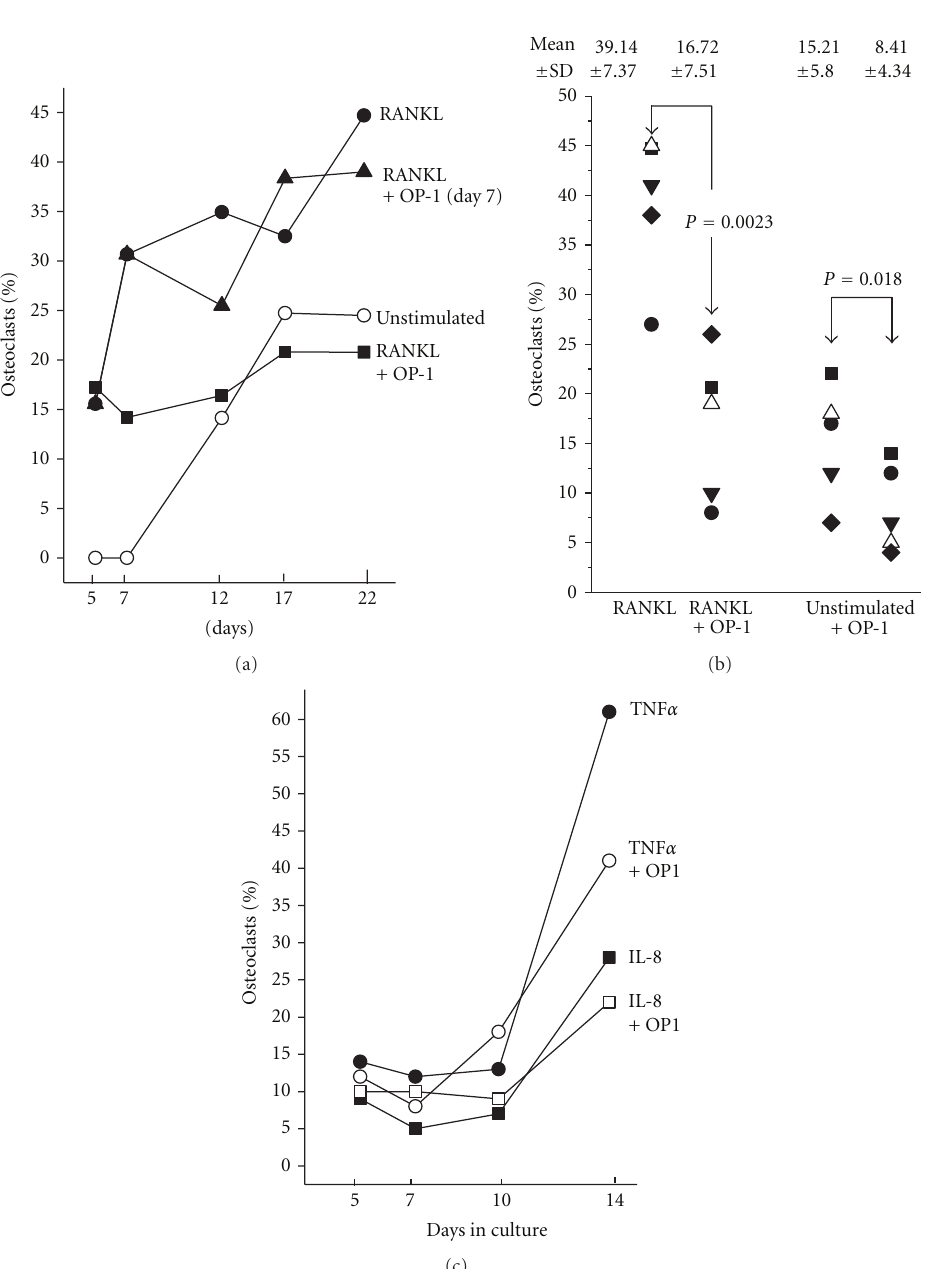
Figure 2: Di ff erentiation of CD14+ monocytes to osteoclasts in culture. (a) Monocytes were cultivated with RANKL (50ng/mL) ( • ), RANKL, and OP-1 (1 μ g/mL) ( (cid:2) ) or cultivated without stimulation ( ◦ ). In parallel, cells were cultivated for 7 days with RANKL, and then OP-1 was added ( (cid:3) ). At days 5, 7, 12, 17, and 22 the number of osteoclasts in relation to the total cell number was calculated (given are the mean values of triplicates with cells from one donor). (b) Monocytes of five individuals (each symbol stands for one individual) were cultivated with RANKL or with RANKL+OP-1 or left unstimulated with or without OP-1. After 22 days the percentage of osteoclasts was calculated (the mean values of the groups ± SD are given; the di ff erence between the groups was calculated using t -test for paired samples). (c) Monocytes were cultivated with either IL-8 (10ng/mL; squares) or TNF α (3ng/mL) with (open symbols) or without (closed symbols) OP-1 and the percentage of osteoclasts was calculated at various times in culture (shown is the mean of duplicates and data of two individuals are